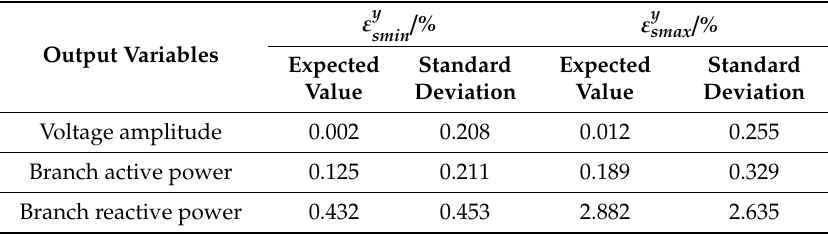
Table 2. Relative error indicators of output variables at Node 30.